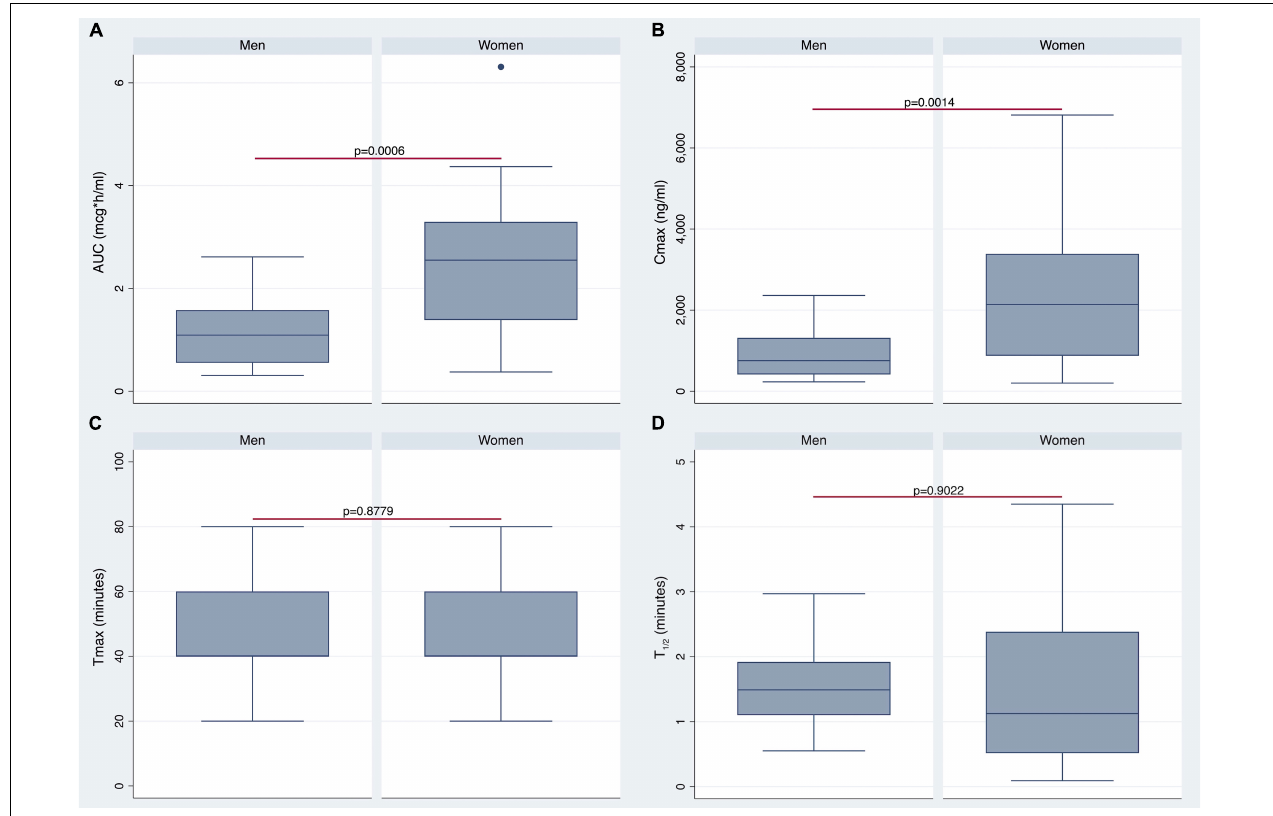
FIGURE 3 | Differences in pharmacokinetics (PK) parameters between men and women. Gender differences in area under the curve (AUC), maximum plasma concentration (Cmax), Tmax, and t 1 / 2 are shown in panels (A–D) ,